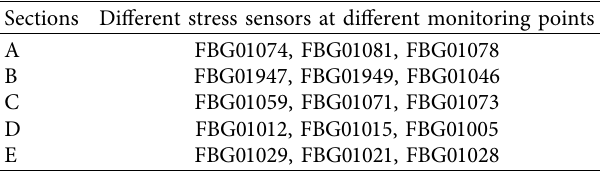
Table 1: Stress sensors of the five monitoring cross sections [12]. Sections Different stress sensors at different monitoring